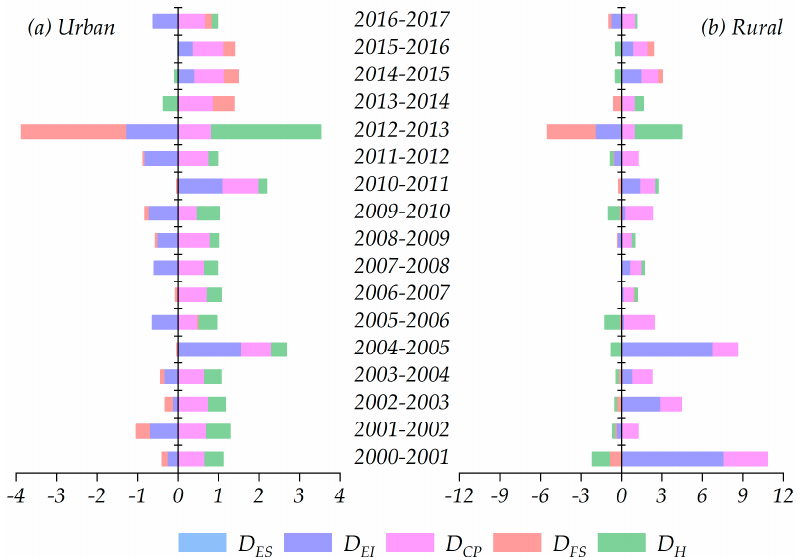
Figure 6. Decomposition of decoupling in Guangdong urban and rural regions during 2000–2017. ( a ) Urban. ( b ) Rural.